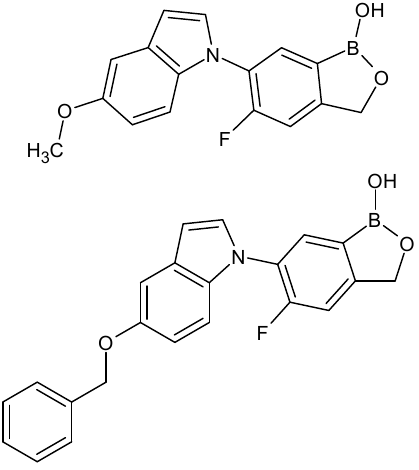
Figure 3. The structures of benzoxaborole analogs with indole moiety.